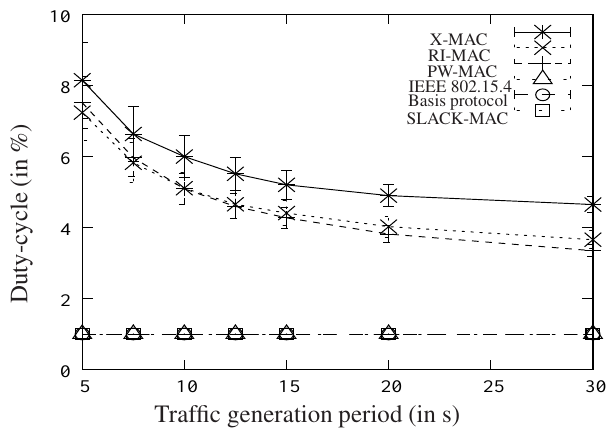
Figure 8. Duty-cycle as a function of the traffic generation period, for a duty-cycle of 1 %, and for several protocols.